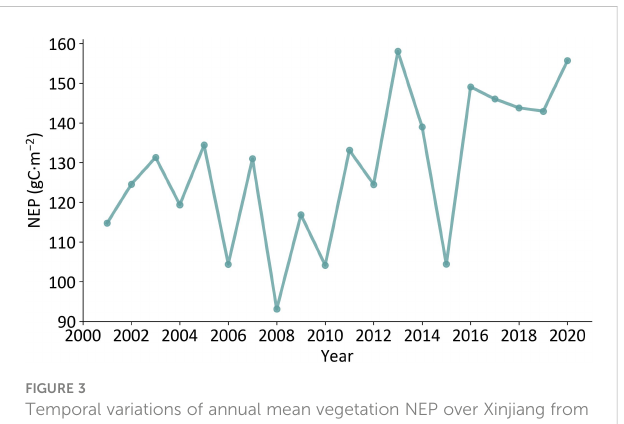
FIGURE 4 Temporal variations of monthly mean NEP over